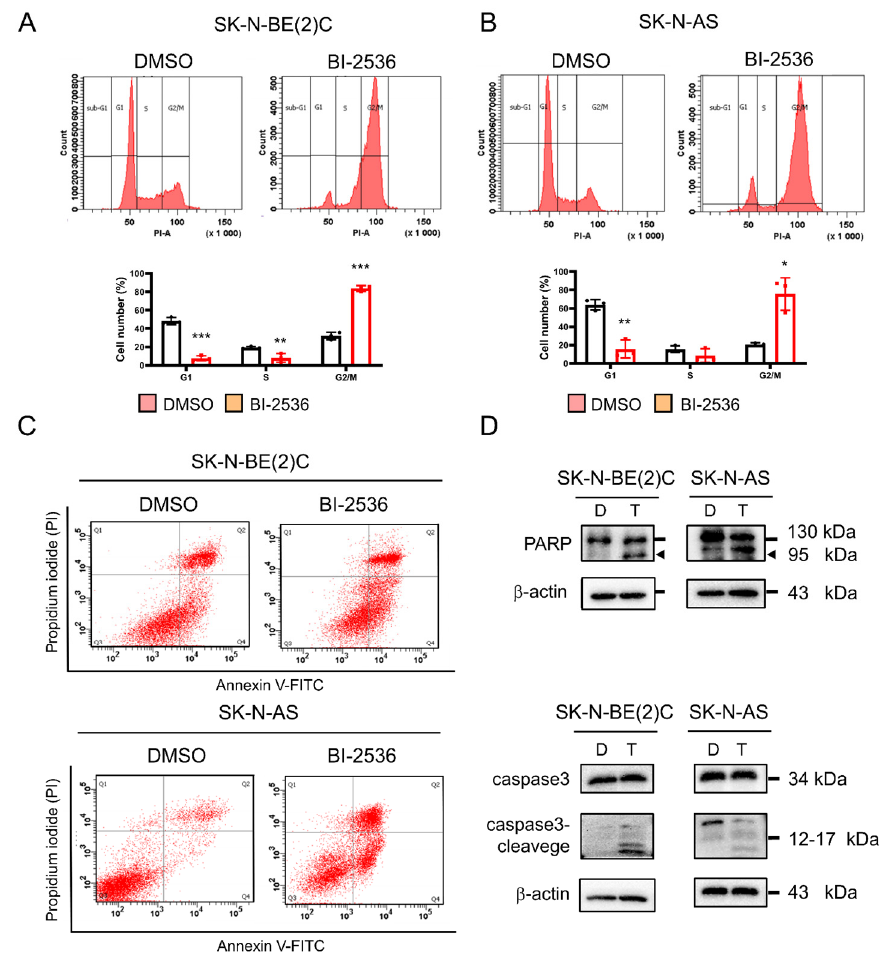
Figure 7. BI-2536-induced G2/M arrest and apoptosis in neuroblastoma cells: ( A ) SK-N-BE (2) C and ( B ) SK-N-AS cell cycle analysis was conducted using flow cytometry. At 24 h after treatment with BI-2536, >70% of the cells were in the G2/M phase. The cells were treated with the half maximal inhibitory concentration (IC 50 ) of BI-2536 for 24 h. Quantitative data on the cell cycle phase for each cell line are shown in below. * p < 0.05, ** p < 0.01, *** p < 0.001 from two-tailed unpaired Student’s t -test to determine whether the mean value of a given group is equal to the corresponding DMSO alone group. ( C ) Cells in Q2 and Q4 represent late and early apoptosis, respectively; both increased after treatment with BI-2536. ( D ) Immunoblot analysis for apoptotic markers in BI-2536-treated neuroblastoma cells. The cleaved forms of poly-ADP ribose polymerase and caspase